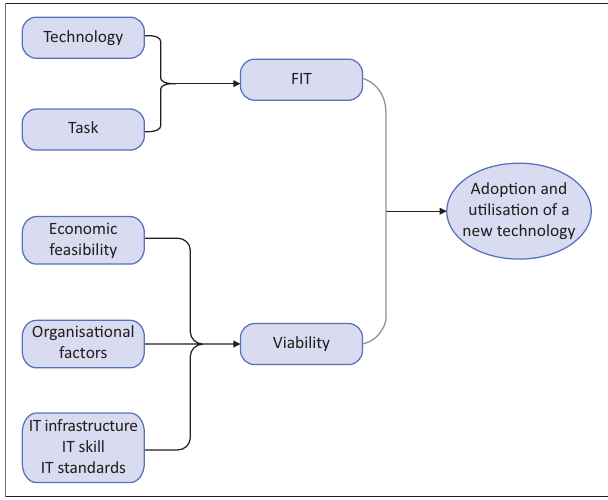
FIGURE 2: Fit and viability